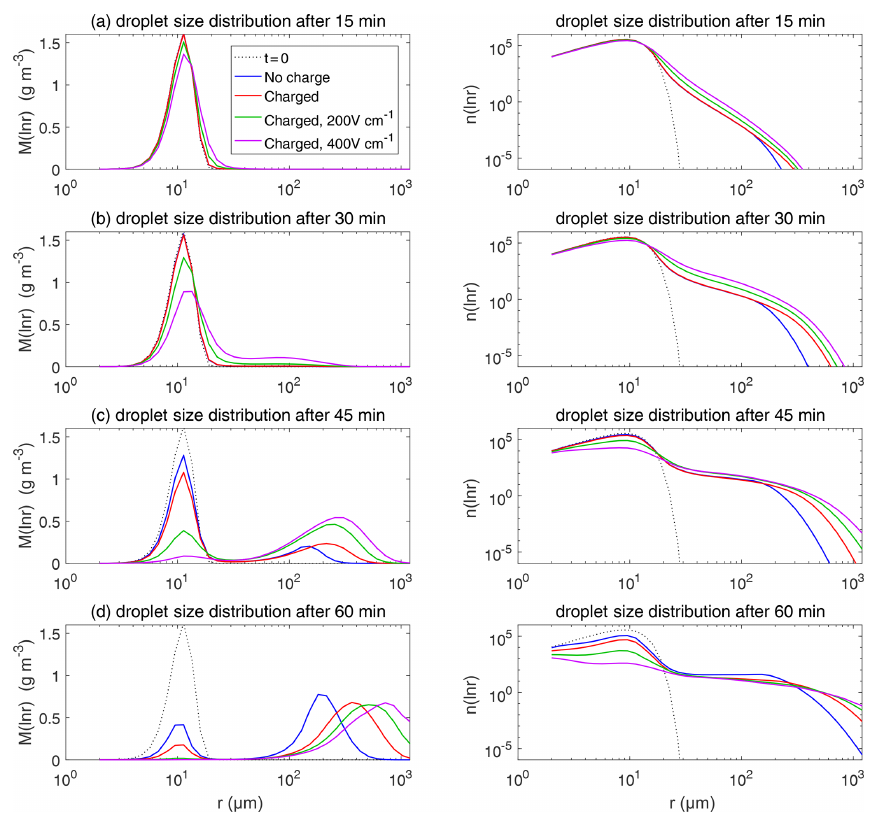
Figure 11. The evolution of the droplet size distribution with initial ¯ r = 9µm.